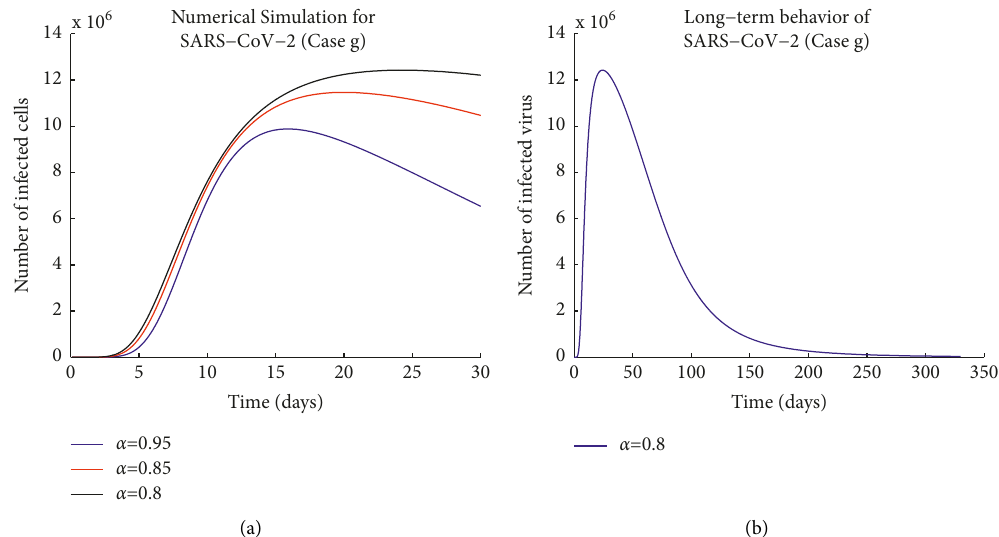
Figure 7: Numerical simulation results of SARS-CoV-2 behavior in patient g (a). Schematic of SARS-CoV-2 long-term behavior in patient g